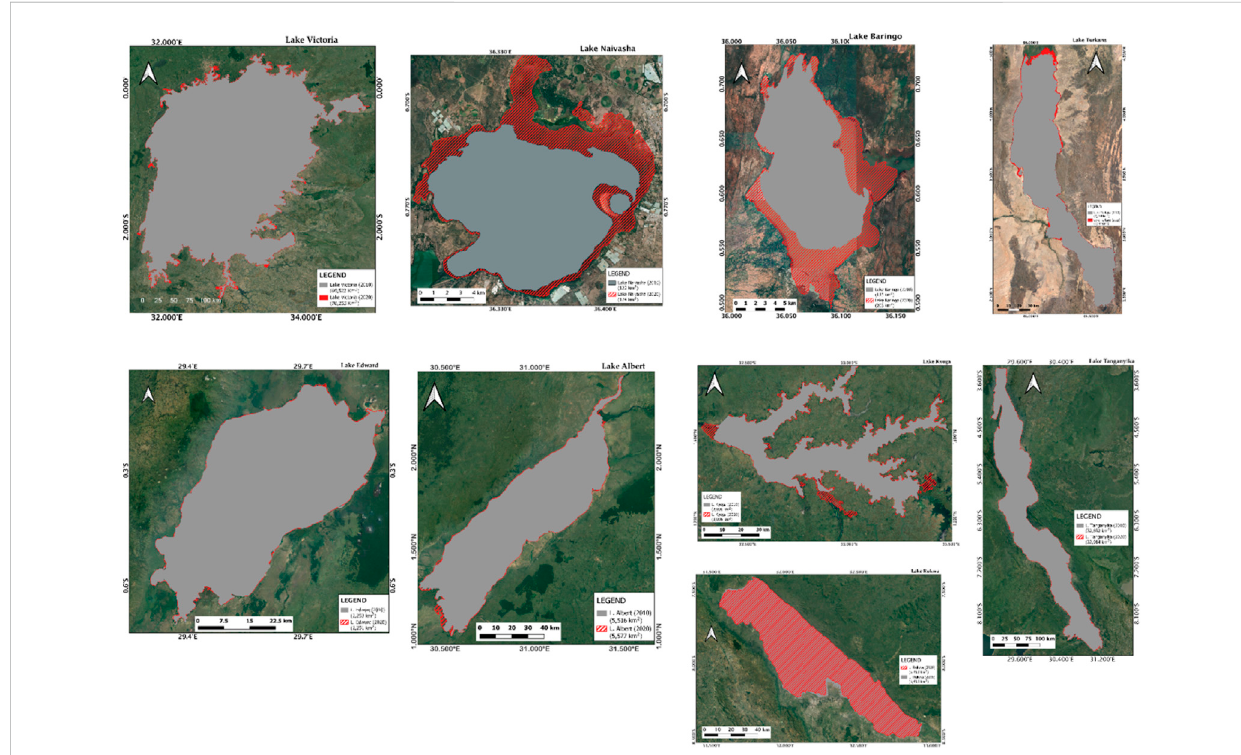
FIGURE 3 Changes in the areal extents of the selected African lakes due to fl ooding. The grey region indicates the lake ’ s shoreline in 2010 and the red shaded region is the shoreline in 2020.